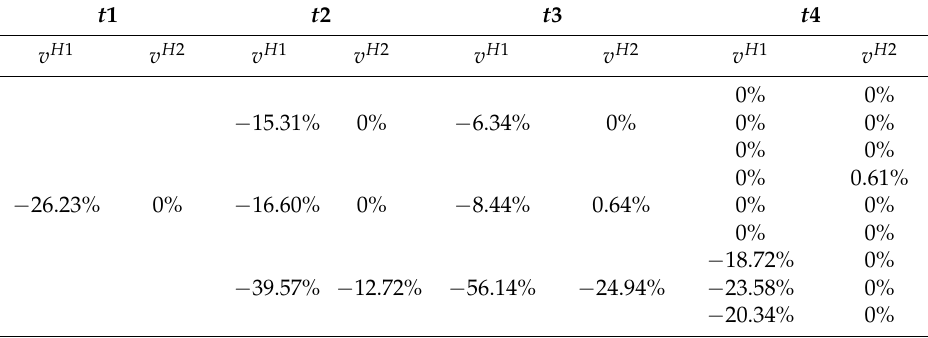
Table 3. Relative change of the hydro reservoir levels between the risk neutral and risk averse cases